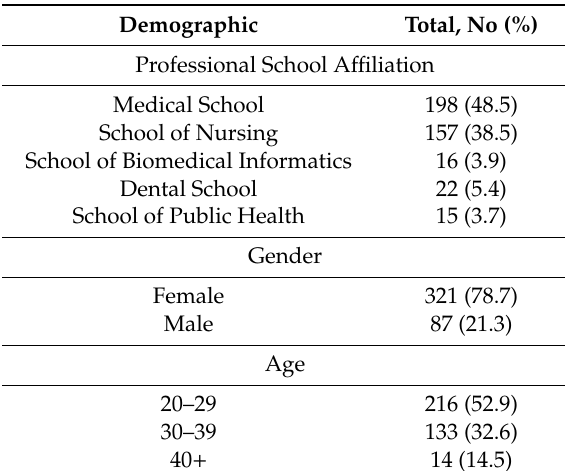
Table 1. Demographics of students participating in the interprofessional education (IPE) program ( n =